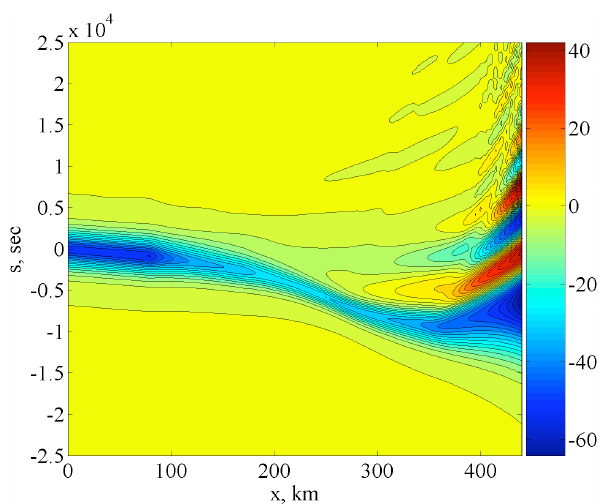
Fig. 14. Contour plot in the space-time domain of an internal solitary wave transformation along cross-section